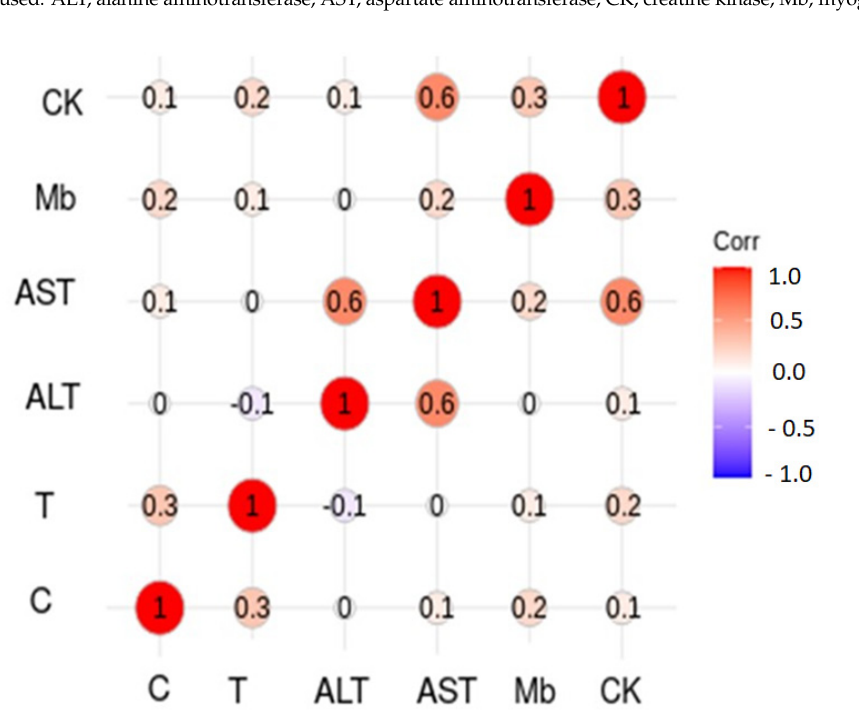
Figure 6. Correlation chart for muscular blood markers and cortisol and testosterone. Mild corre- lation = 0.3–0.5 and strong correlation > 0.6. Abbreviations used: AST, aspartate aminotransferase; ALT, alanine aminotransferase; C, cortisol; creatine kinase; Mb, myoglobin; T, testosterone; CK, creatine kinase.